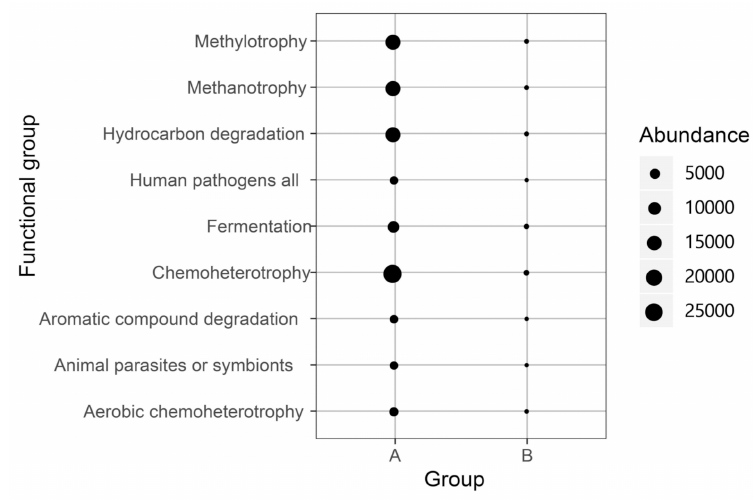
Figure 7. The bubble plot of the function groups predicted against the FAPROTAX database for G. haimaensis (Group A) and A. marissinica (Group B).